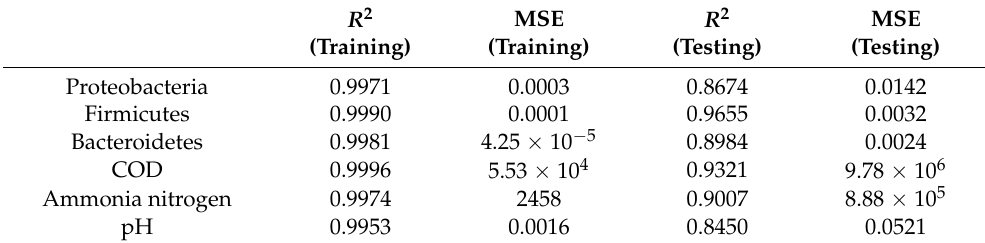
Table 10. Comparison of the GBDT prediction models based on PCA.